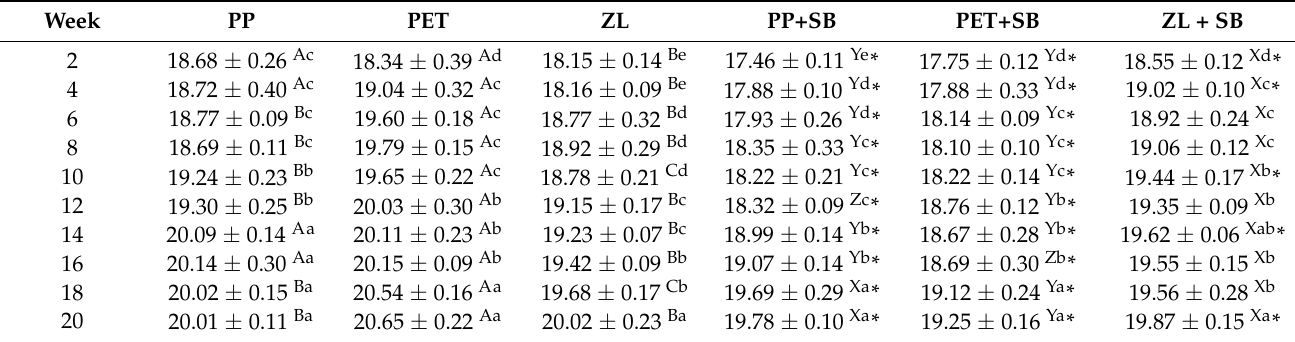
Table 2. Changes in moisture content of dried chili fish paste stored in various packaging at room temperature.